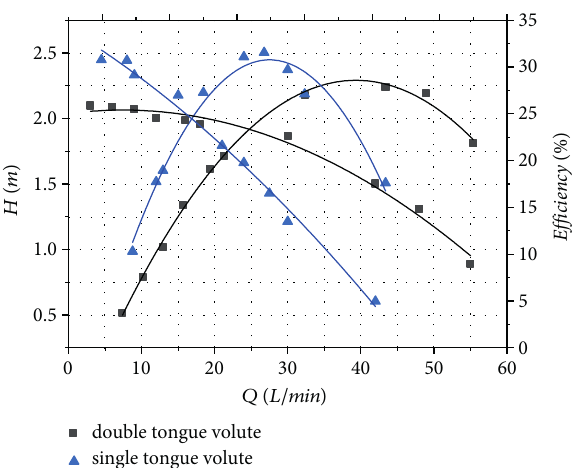
Figure 17: Comparison of pump performance among double and single tongue volute.